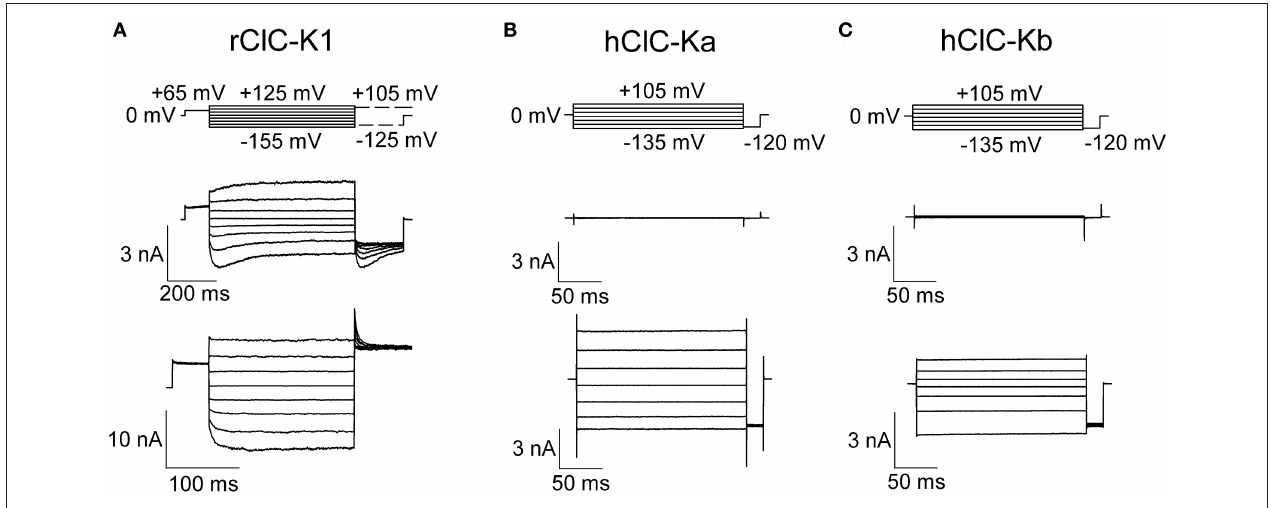
Figure 2 | representative current recordings of ClC-K channels heterologously expressed in mammalian tsA201 cells. Whole-cell patch clamp recordings of macroscopic currents of rClC-K1 (A) , hClC-Ka (B) , and